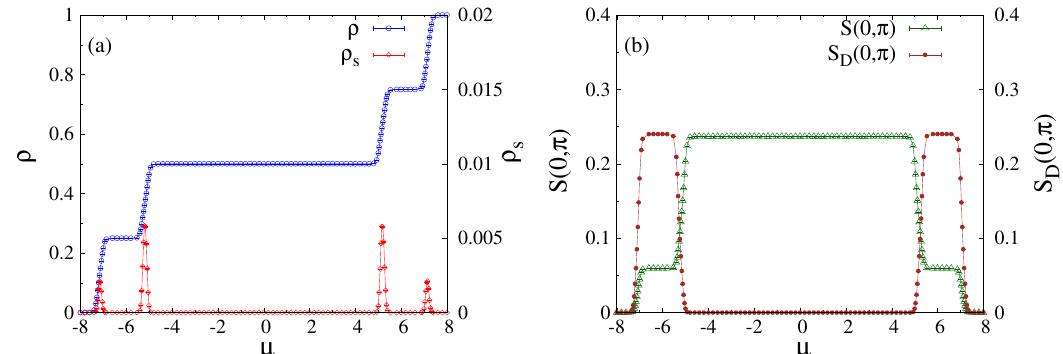
= 6.0 as a function of the chemical Figure 2: Plots of the four order parameters for W 0 potential µ : (a), density ρ and superfluid density ρ ; and, (b), structure factor S ( 0, π ) s ( 0, π ) . Here t = 1.0 and the calcualtions are performed and dimer structure factor S D on a 20 × 20 periodic honeycomb